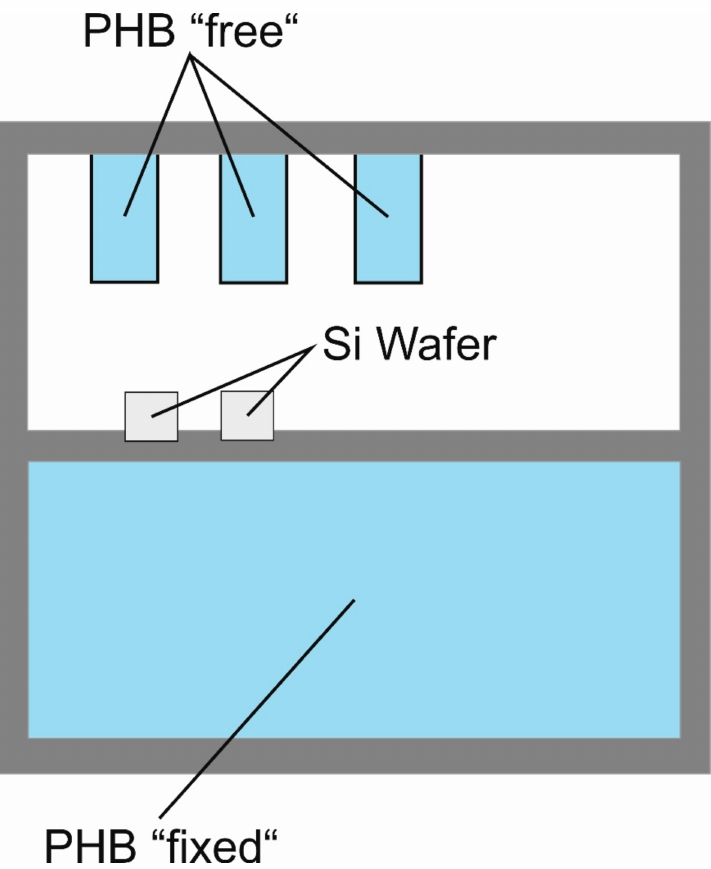
Figure 1. Samples holder set-up. The “free” polyhydroxybutyrate (PHB) samples sized 1 × 2 cm at the top are free on three sides; the size of the “fixed” sample is 5 × 10 cm, which is clamped on all four